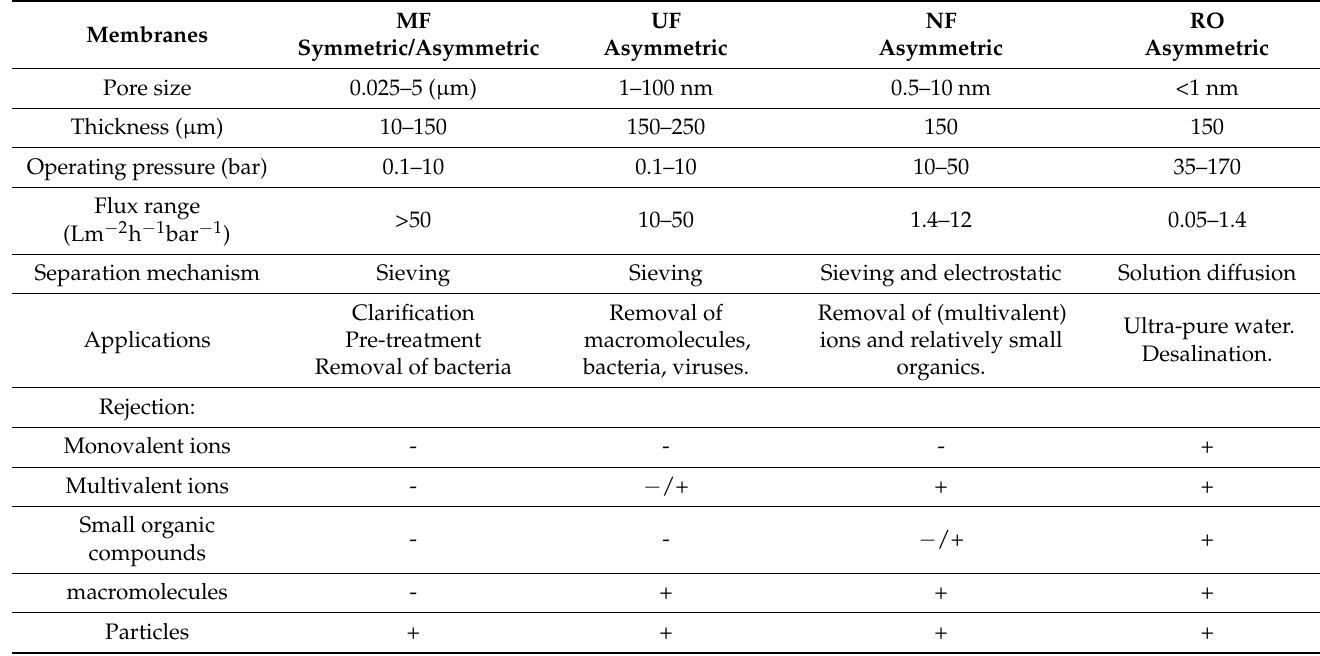
Table 1. Outline of membrane processes and their characteristics in order of decreasing nominal pore sizes [91,94,95]. MF UF NF Membranes Symmetric/Asymmetric Asymmetric Asymmetric